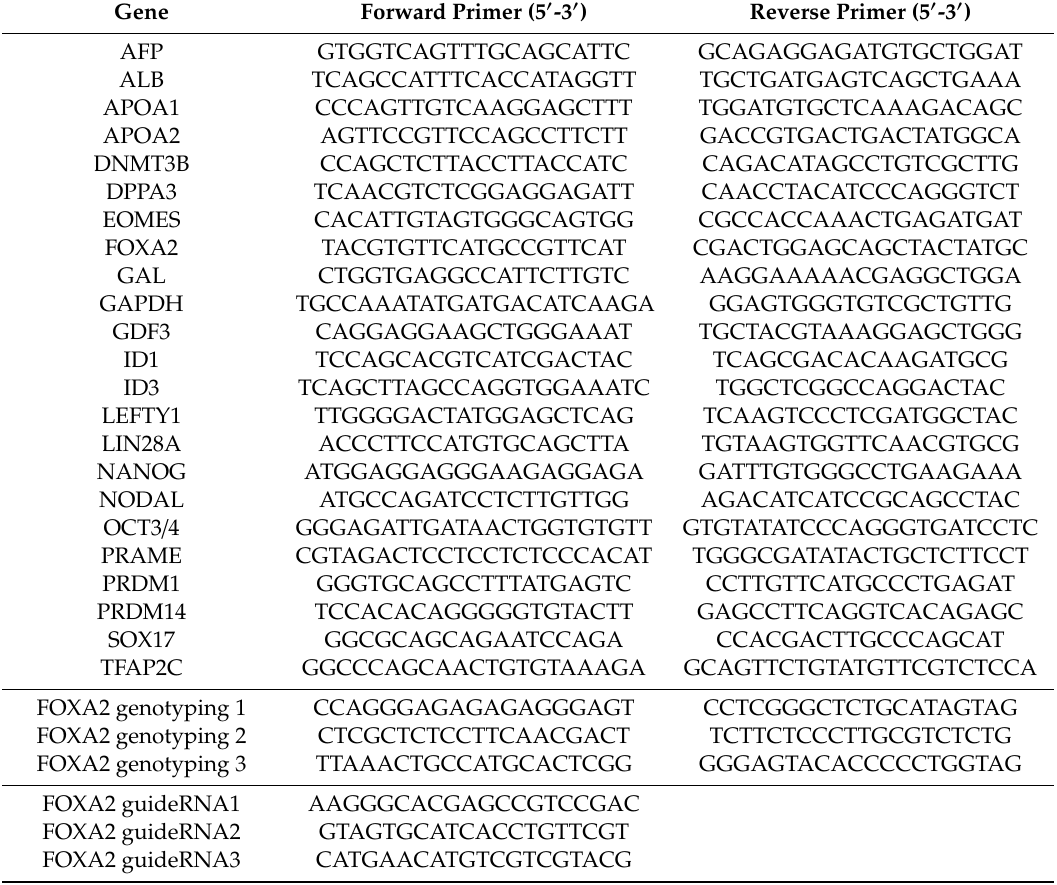
Table 1. Oligonucleotides used in this